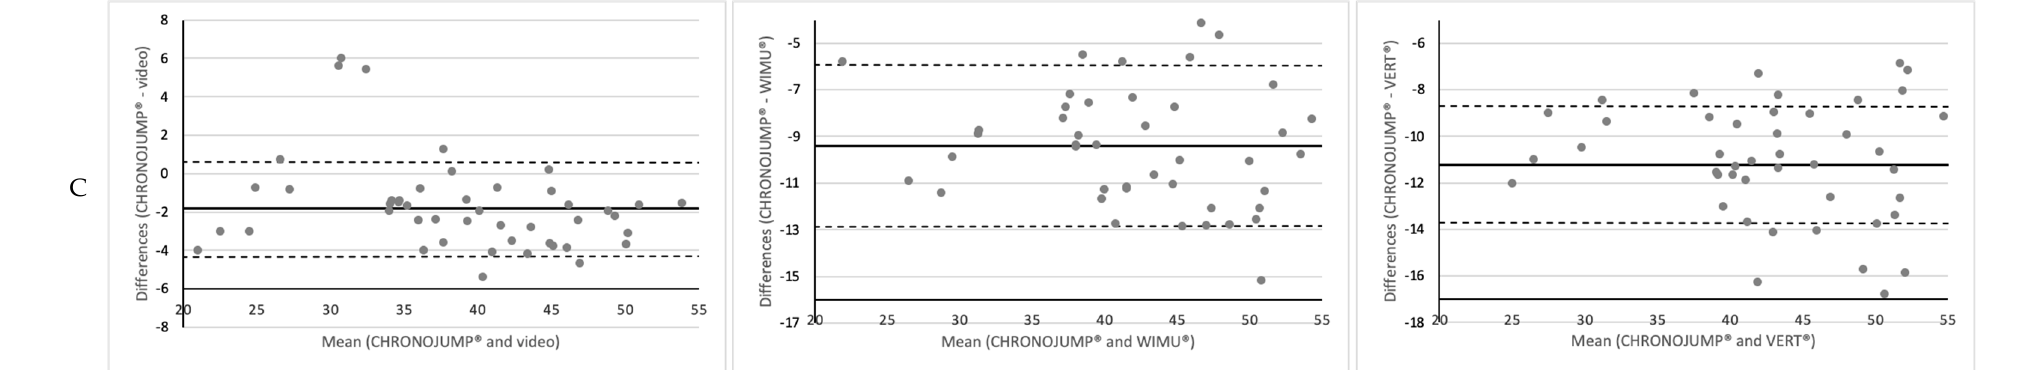
Figure 4. Bland–Altman plots comparing CHRONOJUMP ® with video and WIMU ® (time fly) according to time fly in ( A ) SJ: squat jump, and ( B ) CMJ: countermovement jump and also the VERT ® in ( C ) Abalakov jump. The variables analyzed were the jump height measured in centimeters.